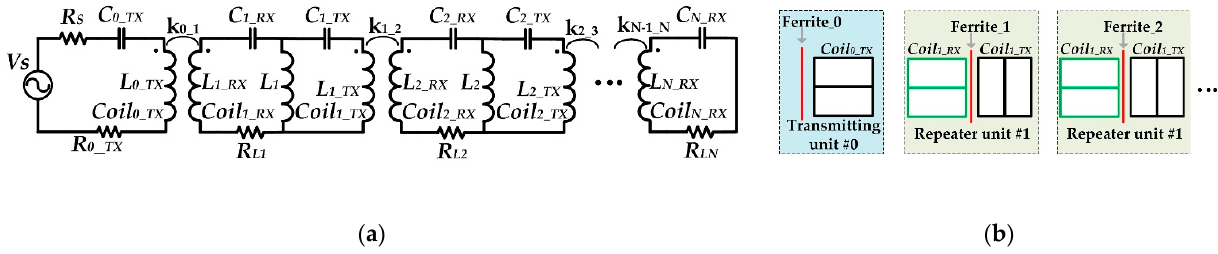
Figure 2. ( a ) Reported WPT repeater structure for gate drivers [5] ( b ) Coil structure of the WPT repeater system [5].